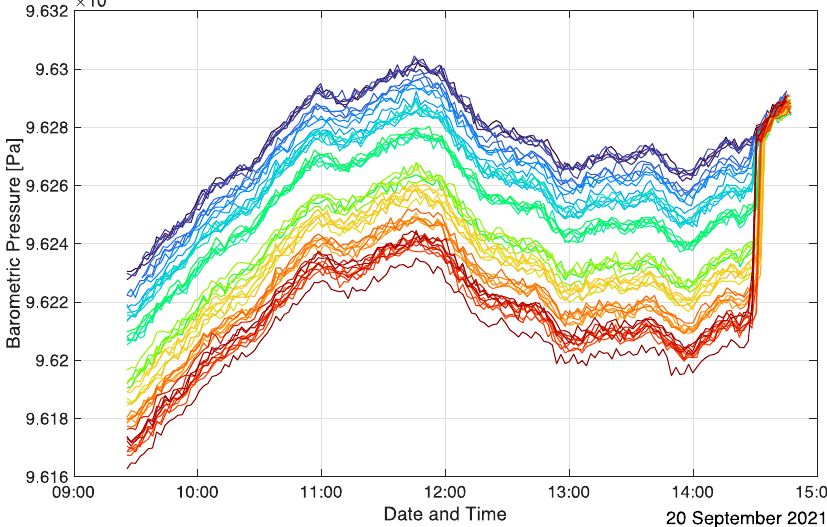
Figure 5. Compensated BMP390 values (after calibration) in an inclined